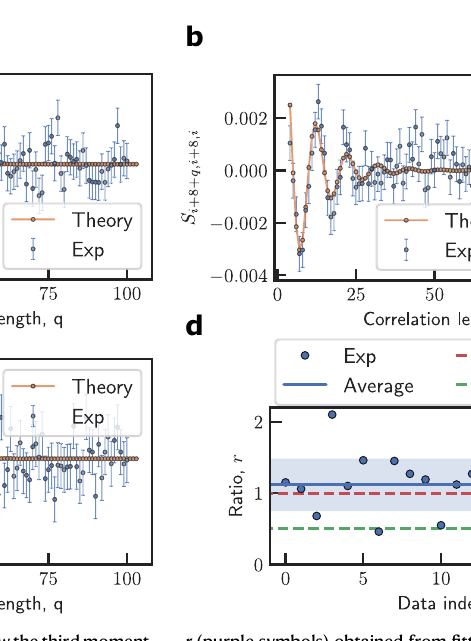
r (purple symbols) obtained from fi tting different data sets (see Supplementary Note 11). The blue line is the mean value of r , and the shadow area is within one standarddeviation from the mean. The red (green) dashedline indicates the value r Q =1 ( r C =1/2) for the total (classical only)